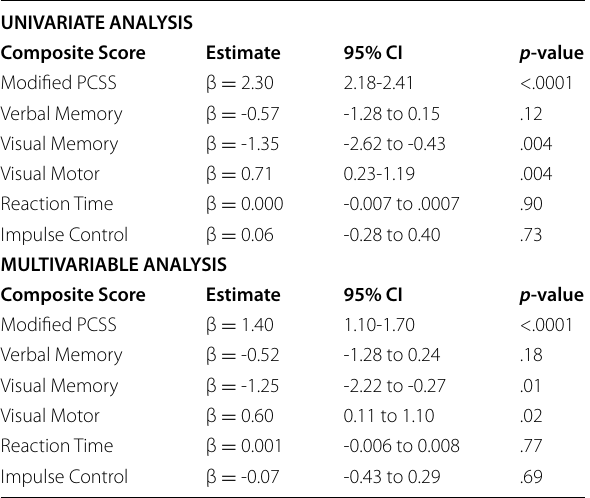
Table 2 Multivariable analysis of the effect of Headache and Migraine Treatment on Baseline Neurocognitive Function UNIVARIATE